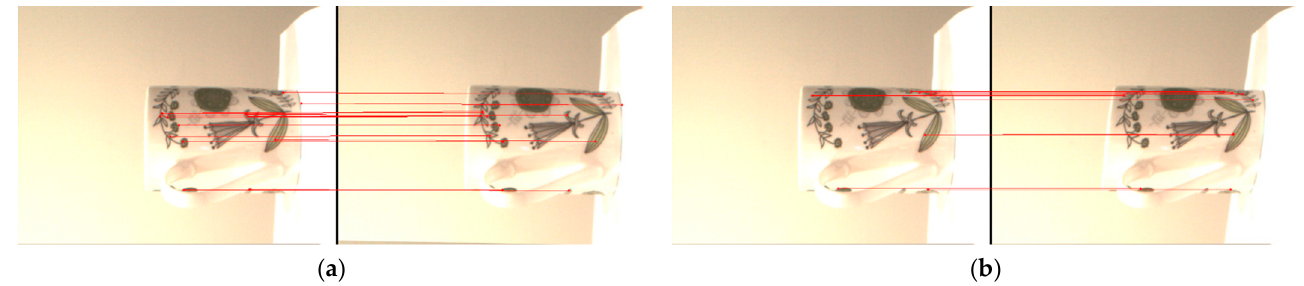
Figure 22. Feature matching results of the original image with ( a ) the rotated and ( b ) the skewed image.